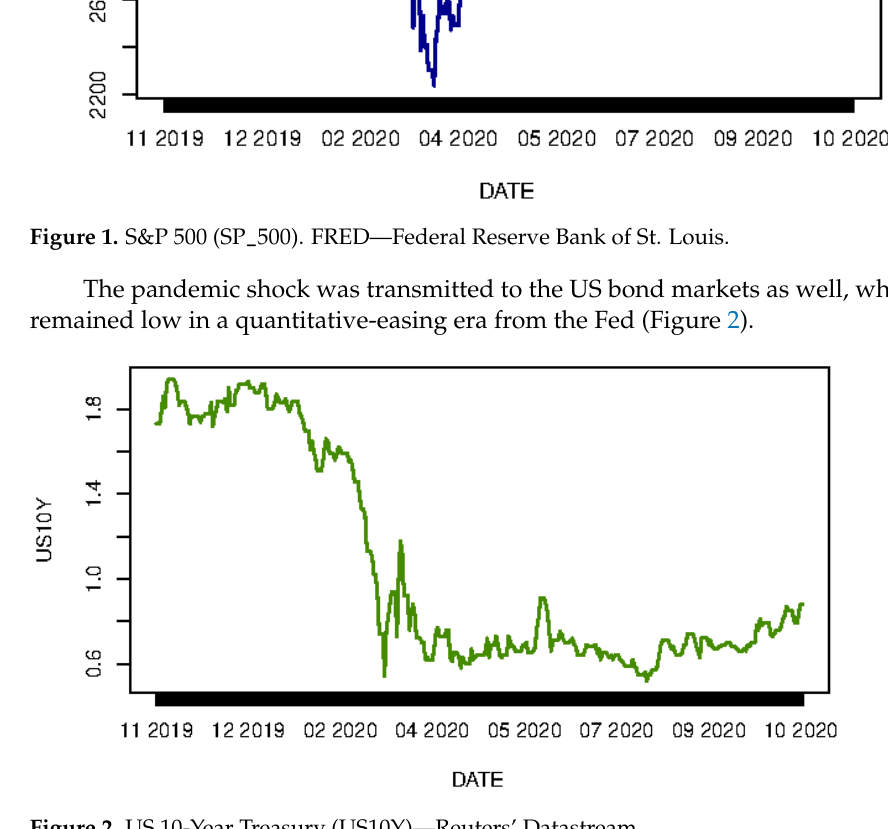
Figure 2. US 10-Year Treasury (US10Y)—Reuters’ Datastream. Is gold a refuge for value? The raw series plot seems to indicate that this is indeed the case (Figure 3).